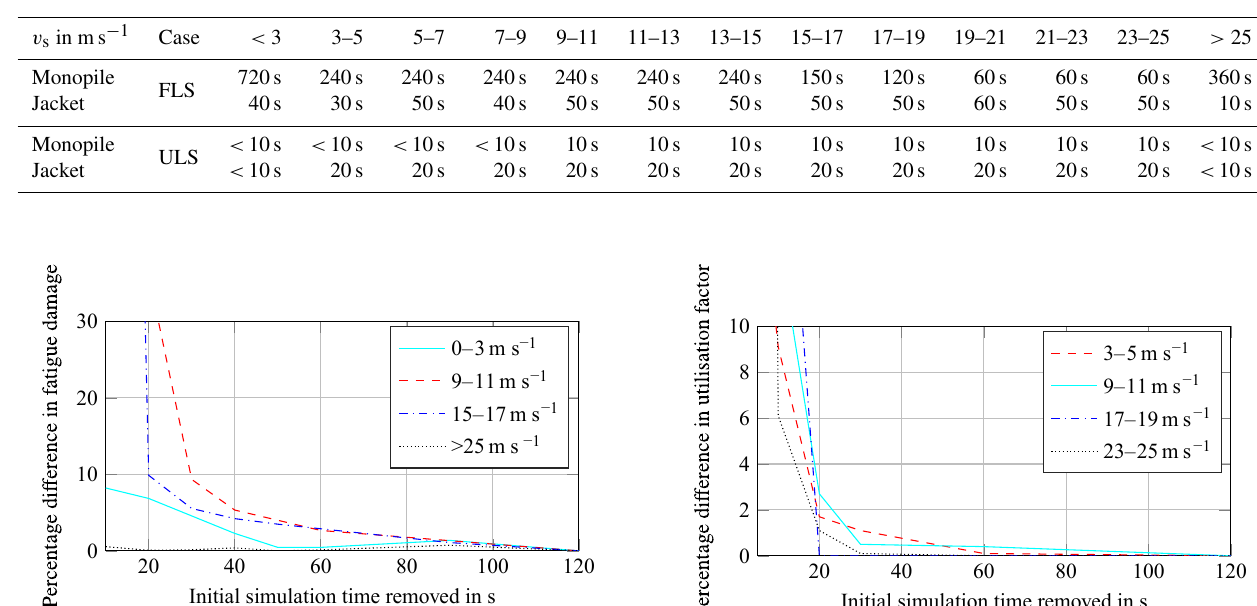
Table 3. Recommended times that should be discarded to exclude initial transients for simulations with OC4 jacket and OC3 monopile substructures for different wind speeds to achieve errors below 5%.